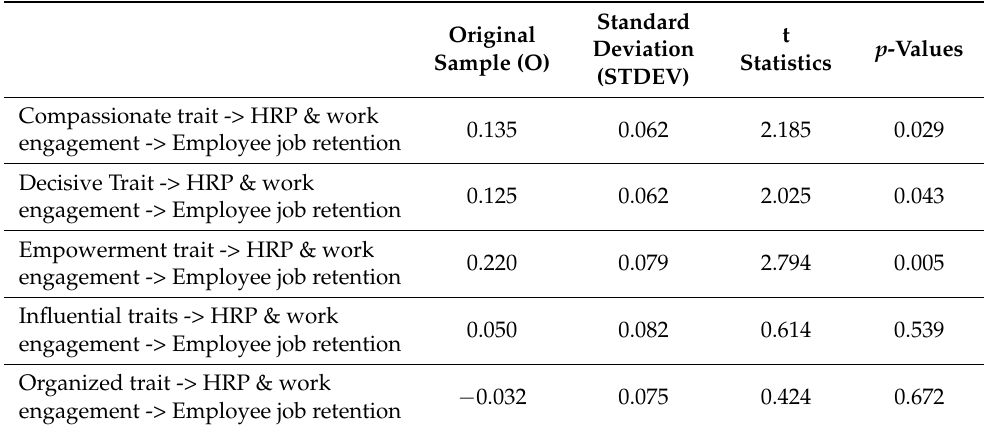
Table 7. Mediation